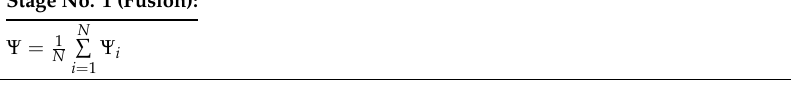
Algorithm 2. The algorithm of the proposed system.